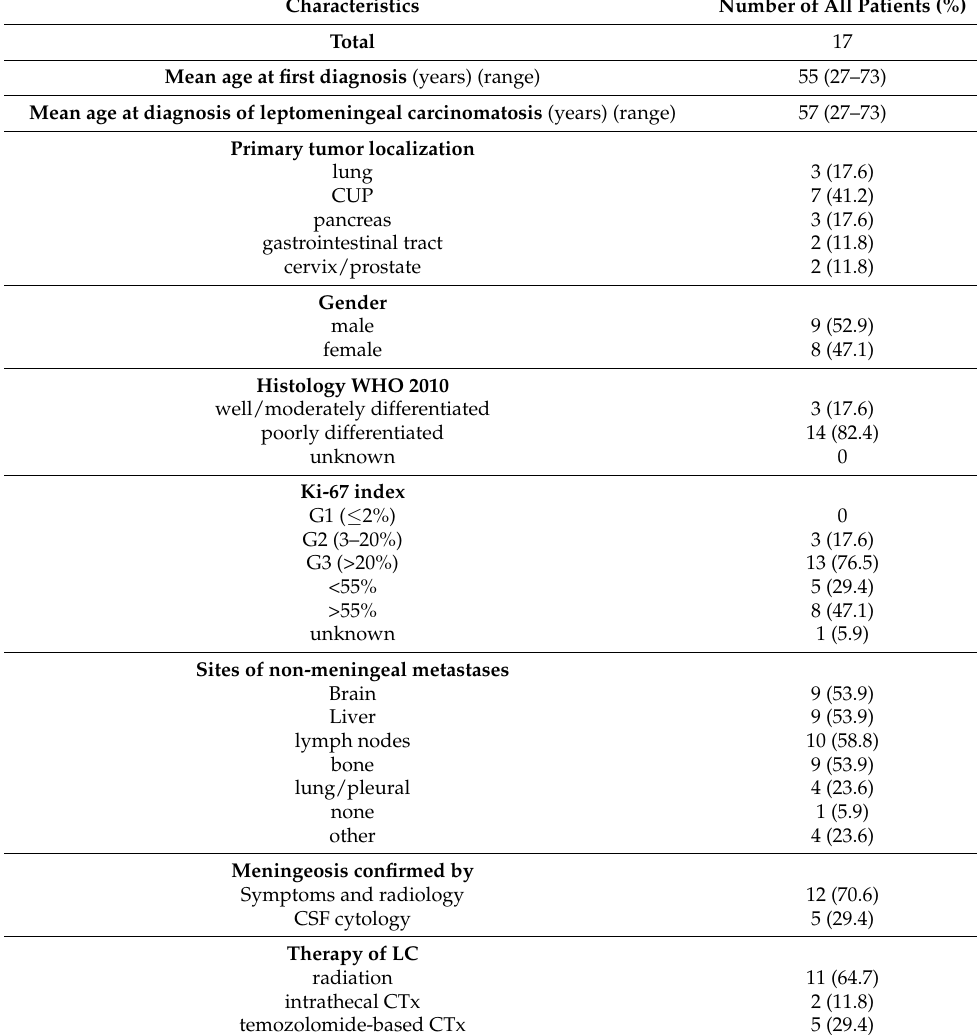
Table 1. Summary of patient characteristics. Abbreviations: NET, neuroendocrine tumors; NEC, neuroendocrine carcinomas; CUP, carcinoma of unknown primary; CTx,